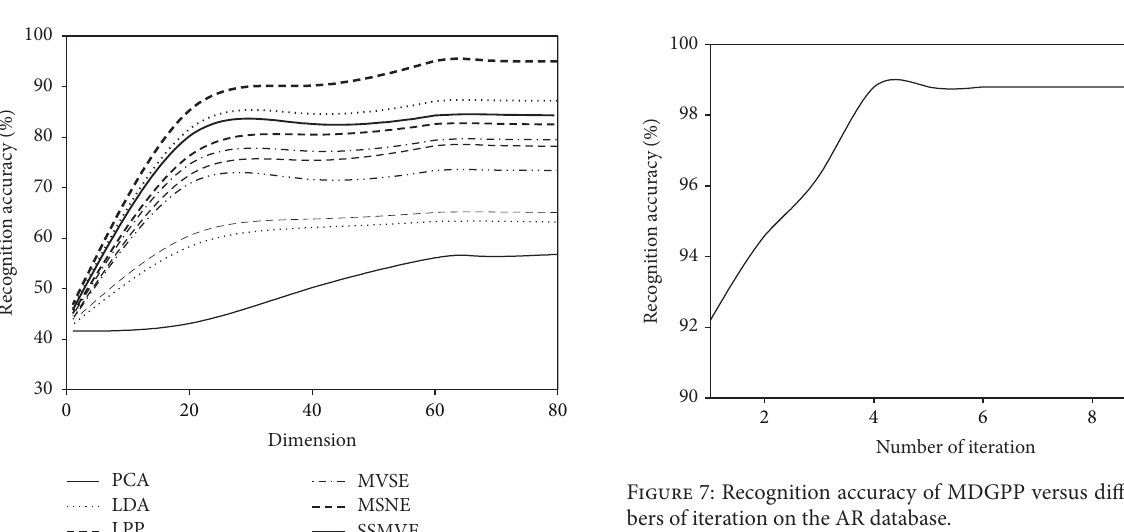
Figure 4: Recognition accuracy versus reduced dimension on the AR database.